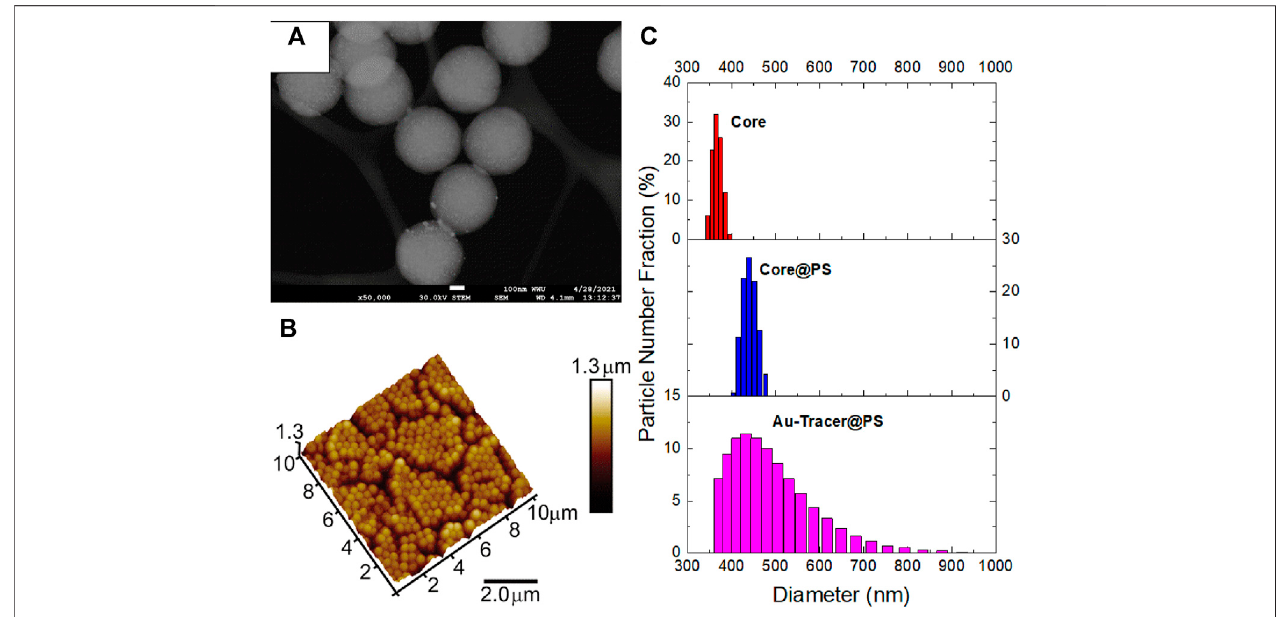
FIGURE 2 | Physical characterization of Au-Tracer@PS particles. (A) SEM images of Au-Tracer@PS particles. (B) Tapping-MAFM image of Au-Tracer@PS particles. (C) DLS data detailing the core size (top) , core@PS size (middle) , and Au-Tracer@PS size (bottom) .